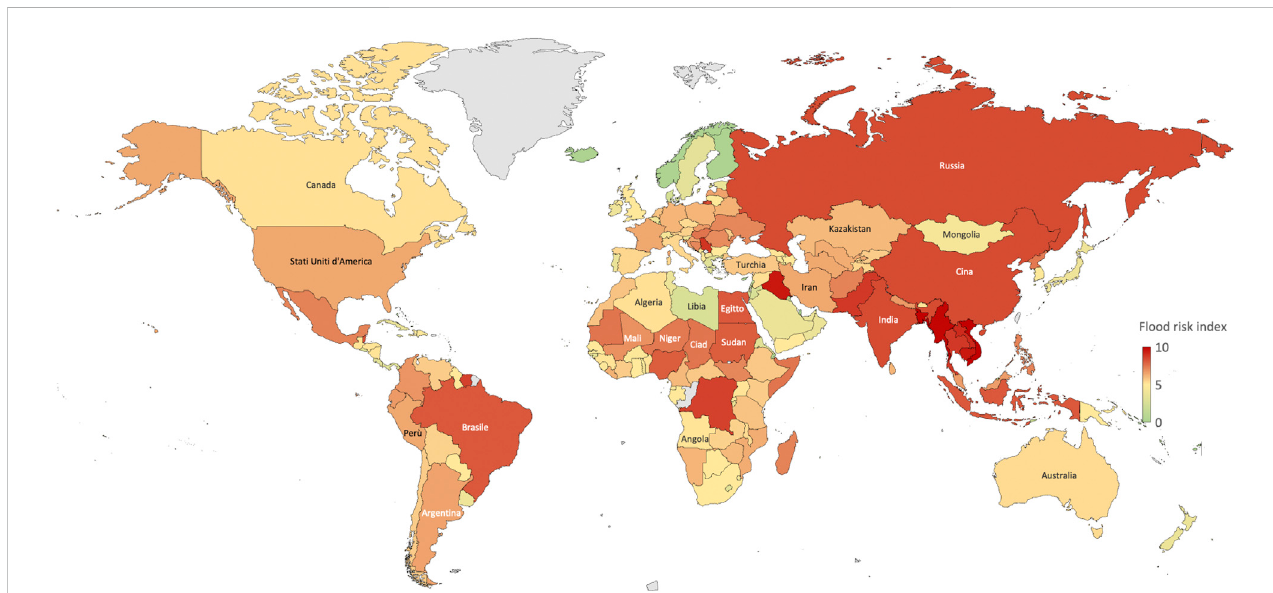
FIGURE 1 2022Floodriskindexreportedfor alltheworld.Theindexcanassume avaluebetween 0and10(the higherthescore,thehigher therisk).Itiscalculated based on the estimated number of people exposed to fl oods per